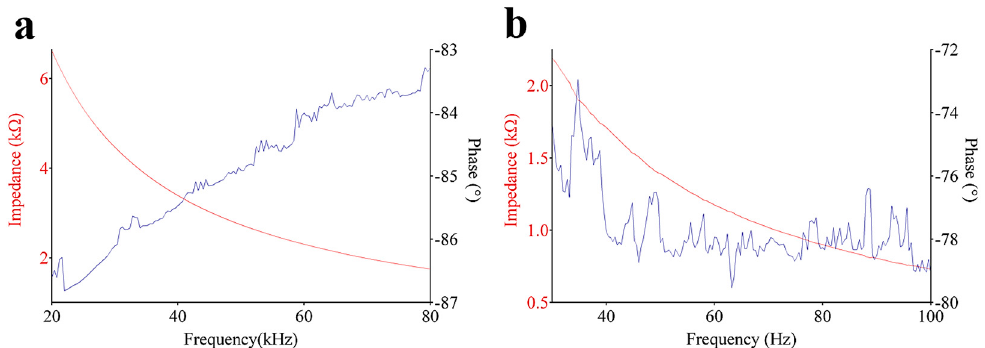
Figure 9. Experimental electrical impedance (module and phase) in the frequency range from ( a ) 20kHZ up to 80kHZ, ( b ) 40kHZ up to 100kHZ, for the Archimedean and Fibonacci spiral-shaped transducers.